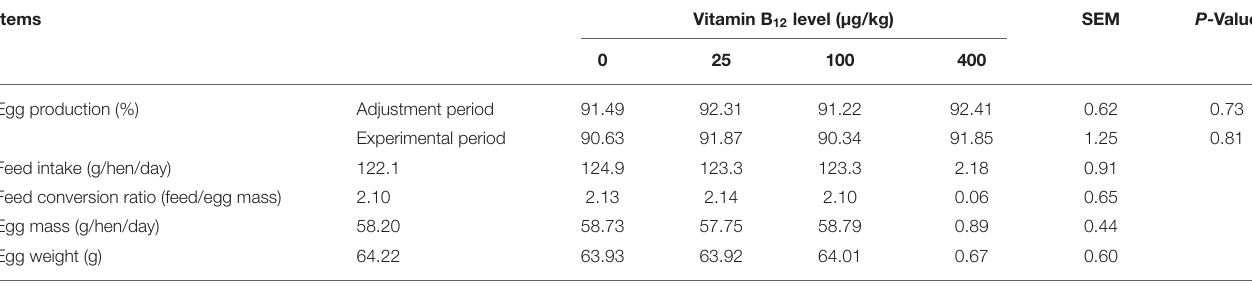
TABLE 3 | Effects of dietary supplementation of vitamin B 12 on the eggshell and egg quality * . Items